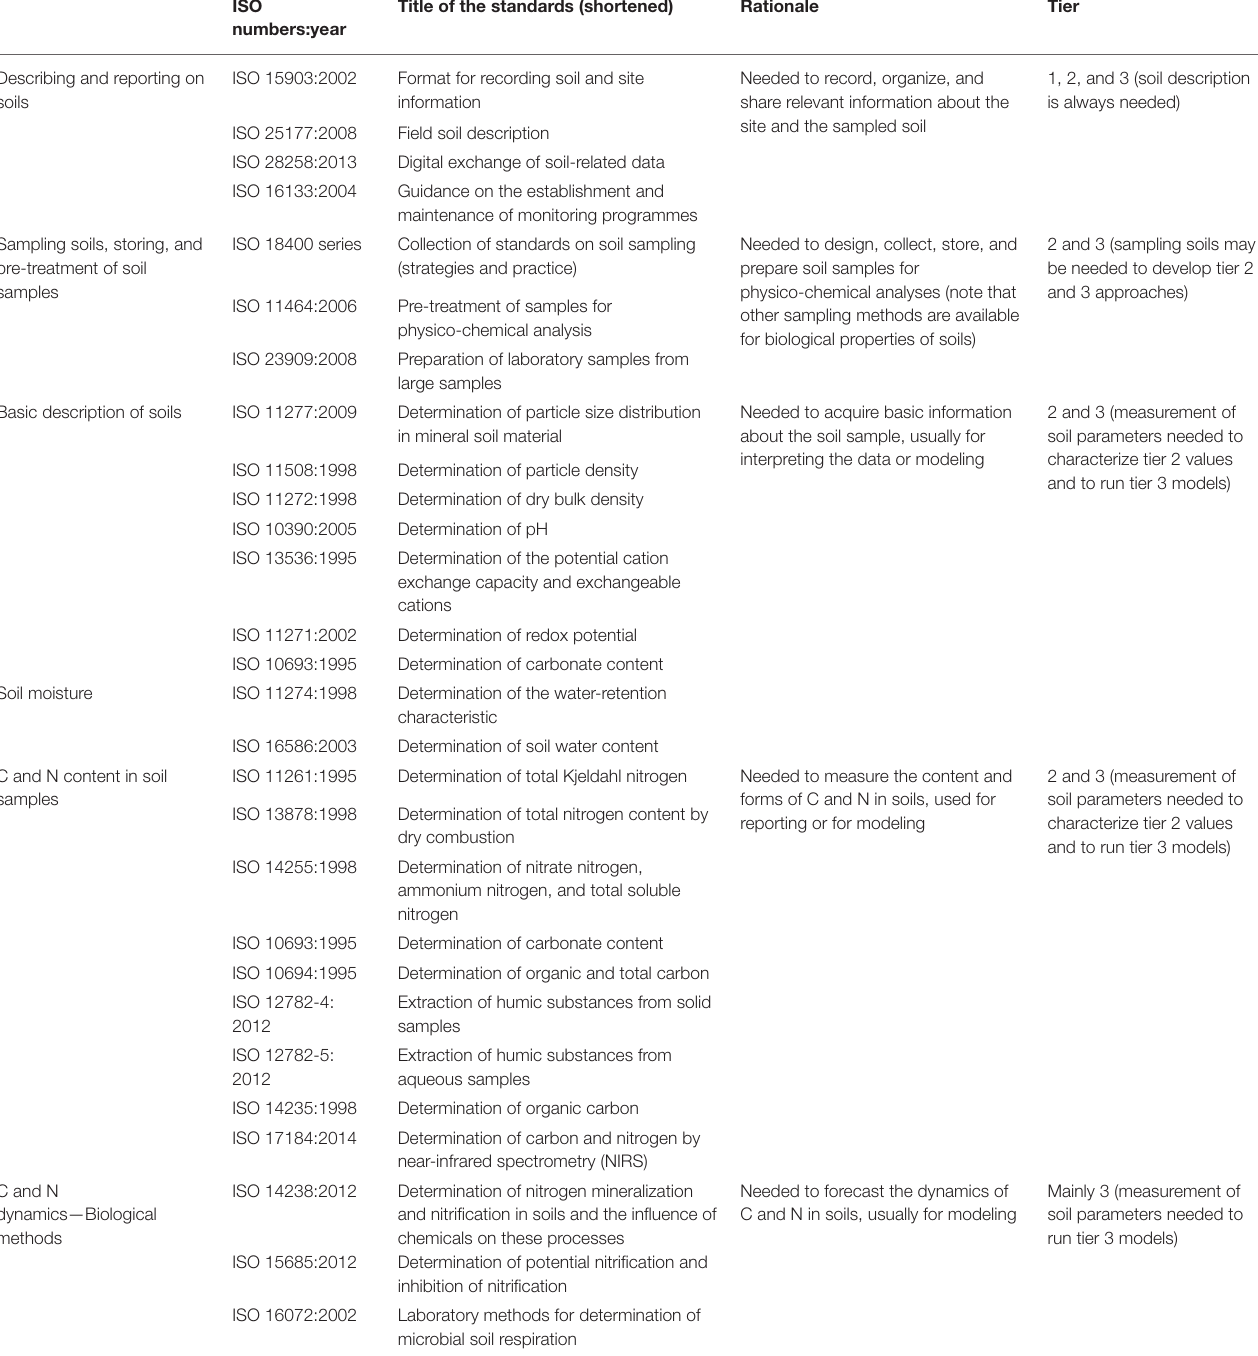
TABLE 1 | Main existing ISO standards needed to measure or model GHGs fluxes, C stocks and controlling parameters of